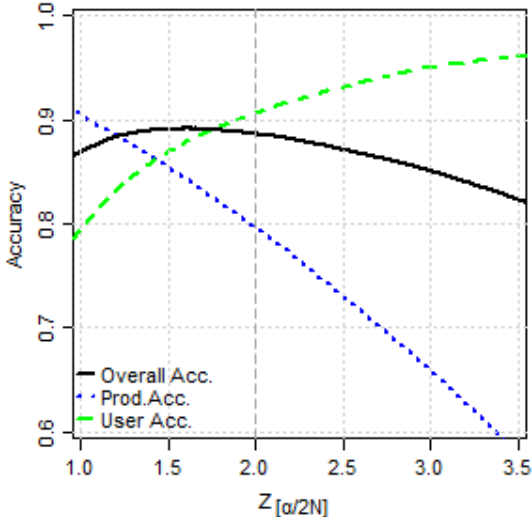
Figure 3. The accuracies of anomaly regions detected at varying z-values of the anomaly determination